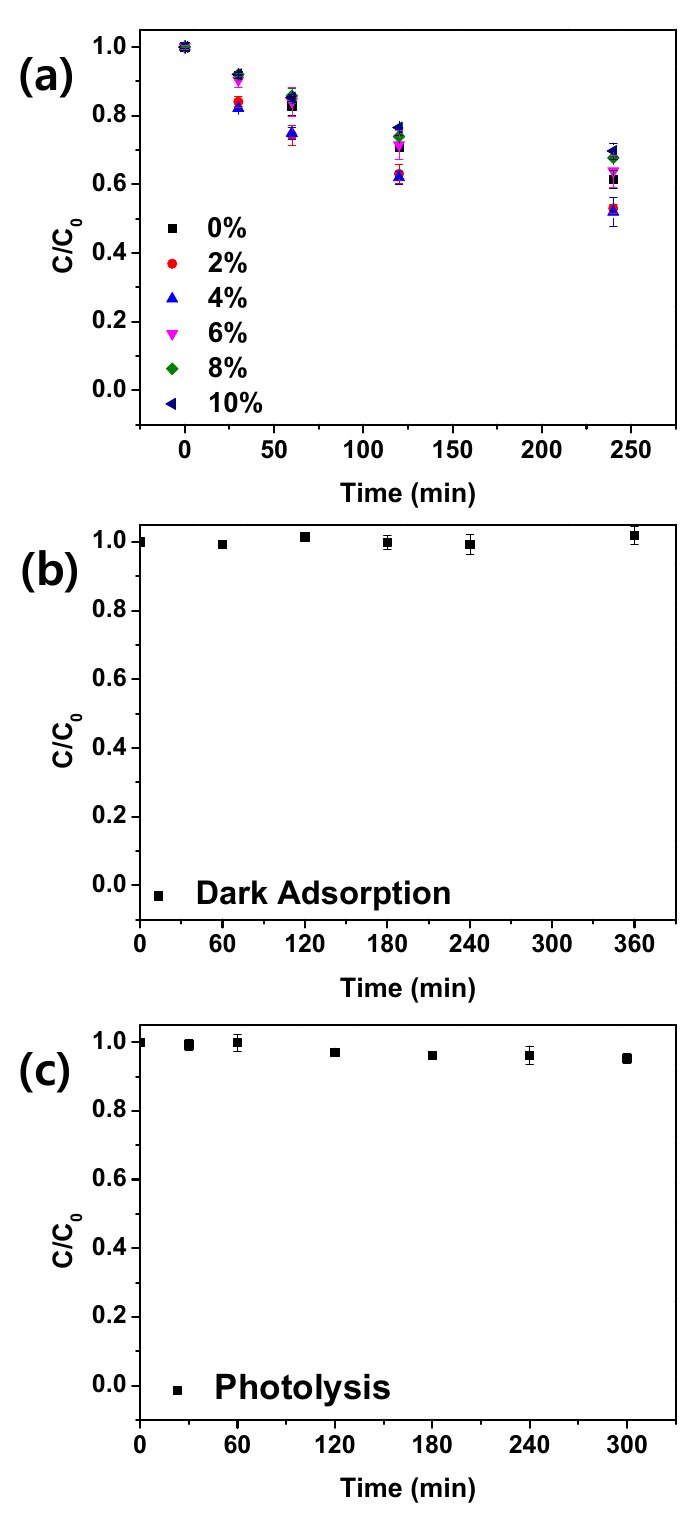
Figure 6. ( a ) Photocatalysis of methylene blue (MB) under visible-light irradiation with different photocatalysts, ( b ) dark adsorption of MB with 4% PANI/TiO 2 , and ( c ) photolysis of MB (MB = 5 μ M, catalyst dose: 0.8 g/L).